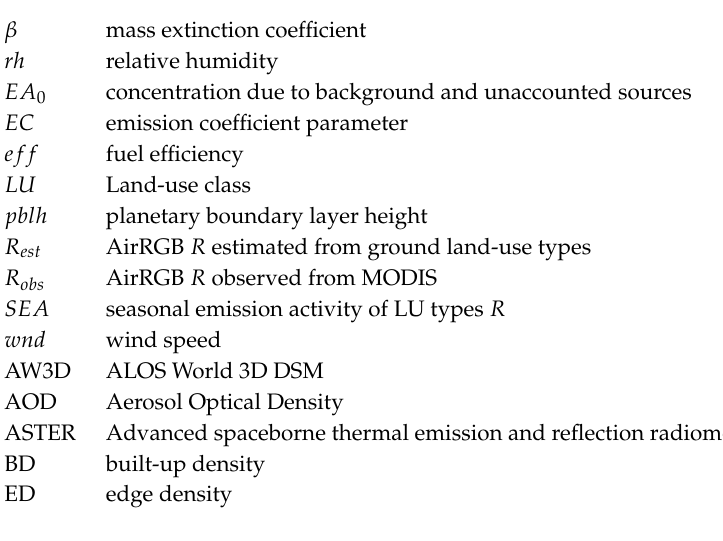
Figure S1: MODIS retrievals are missing during months of June, July and August due to which monthly mean of MODIS AOD is much lower than AERONET AOD over the Kanpur city, India (a). In (b) the difference mean monthly AOD from AERONET and MODIS show difference is maximum during the Monsoon months, Table S1: Assumed distribution of seasonal emission activity parameter ( SEA mon ). For any source SEA mon represents ratio of emissions in any month mon compared to its maximum monthly emission, Table S2: Pearson correlation between coefficient obtained R est and R obs when the SEA was set according to Table 2, Table S3: Pearson correlation between coefficient obtained R est and R obs to compare predictions from the model trained on interpolated R values for rainy months, and the model trained on non-interpolated and rainy months discarded R values, Table